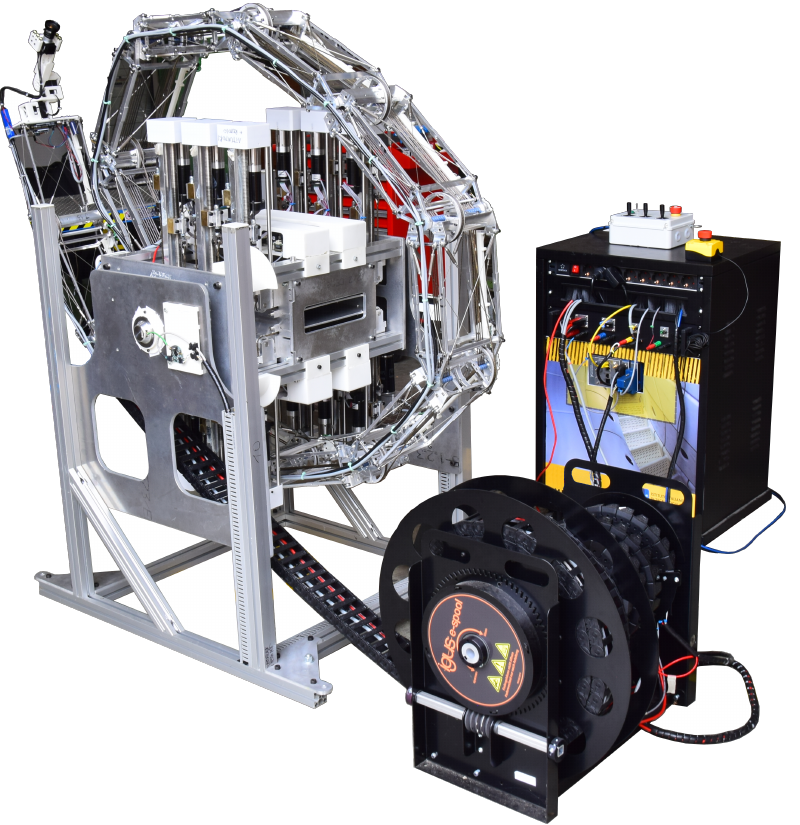
Figure 3. The whole robotic system in its parking position that is enclosed within a volume whose dimensions are 152 cm × 88 cm × 158 cm ( L × W × H )